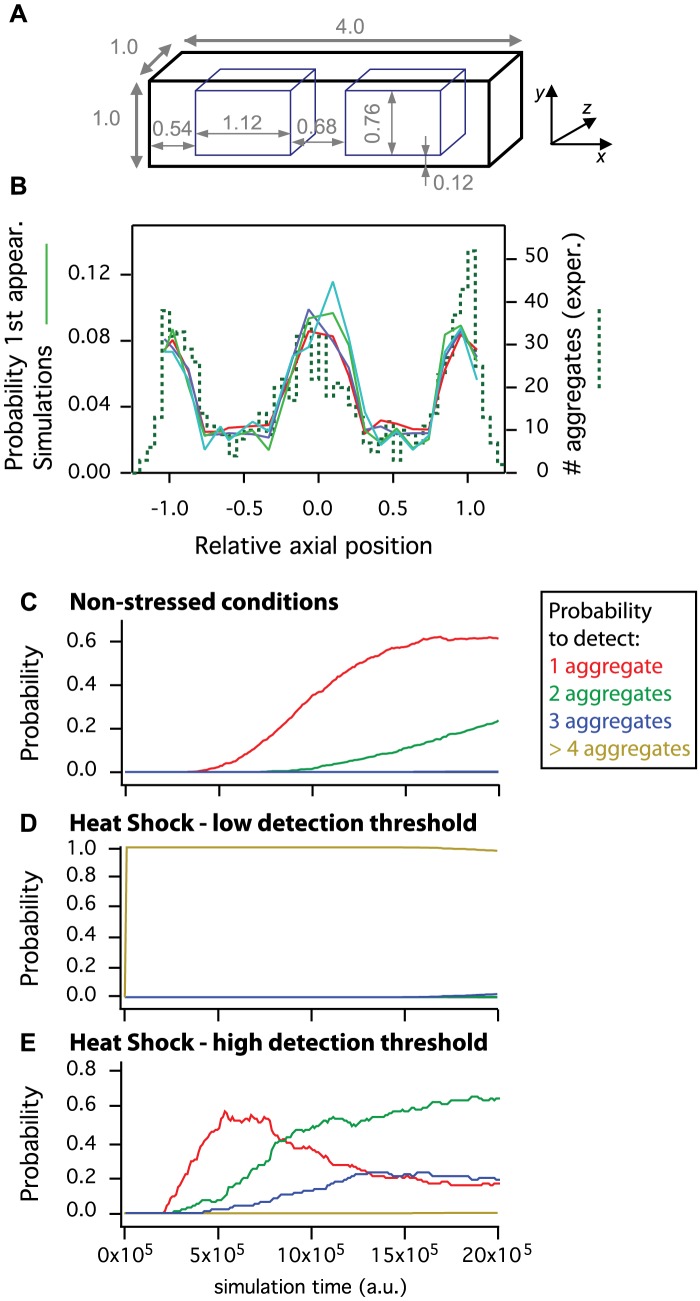
Individual-based models of chaperone protein diffusion and aggregation.(A) Geometry of the 3D model used in individual-based models for E. coli intracellular space. Numbers indicate distances in µm. The blue boxes inside the bacteria locate the nucleoids, where increased molecular crowding is modeled by the insertion of bulk immobile obstacles. (B) Comparison between simulations and experiments of the localization at first detection of the protein aggregates along the long axis (x-axis). The full lines show the spatial distributions extracted from the simulations with different detection thresholds (an aggregate must contain at least 5, 10, 20 or 50 monomeric proteins, respectively, to be detected). Total number of proteins in the simulations Np = 100. The dashed line is an histogram showing the distribution of the experimental data. (C–E) Time-evolution of the probabilities to observe exactly 1 (red), 2 (green), 3 (blue) or more than for 4 (brown) distinct aggregates simultaneously in the simulations. The simulations emulated non-stressed conditions (C), with Np = 100 total proteins and aggregate detection threshold = 30 or heat-shock triggered aggregation, with Np = 7,000 total proteins and aggregate detection threshold = 30 (D) or 1750 (E).